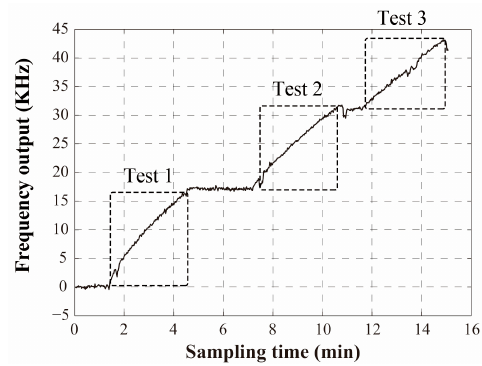
Figure 18. Frequency output of the SAW based PM 2.5 sensor for polystyrene latex (PSL) particle tests.